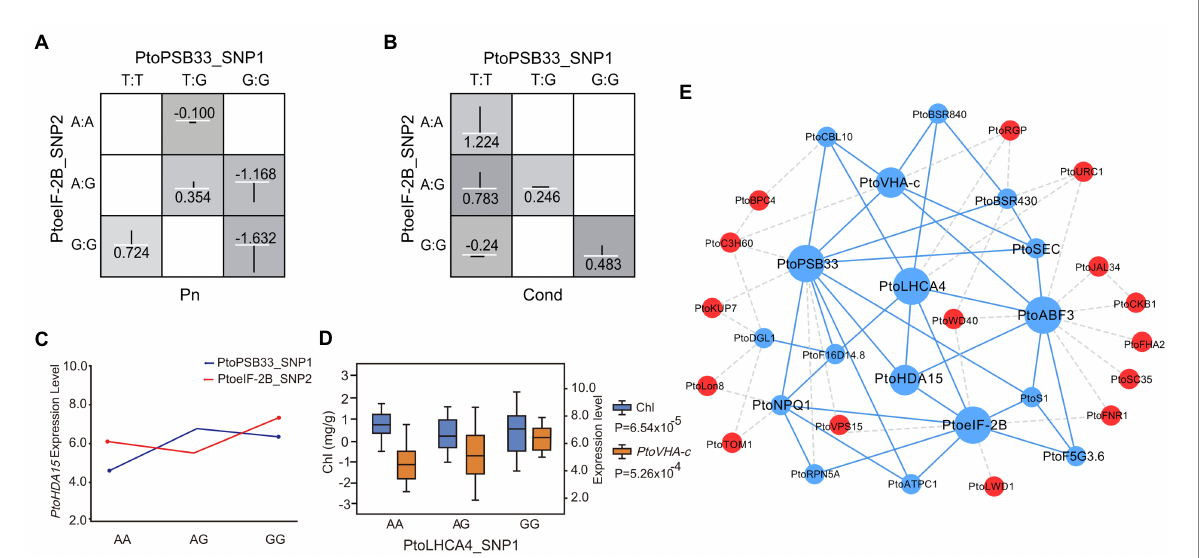
FIGURE 5 Integration of epistasis and eQTN analyses identifies factors involved in the response to drought stress. (A) and (B) Photosynthetic-trait epistatic effects of different genotypic combinations. (C) Pairwise interactions between PtoPSB33_SNP1 and PtoeIF-2B_SNP2 associate with the expression of PtoHDA15 with different genotypic combinations at the two loci. (D) Box plots for Chl (blue) and PtoVHA-c expression (orange) plotted as an effect of genotype at PtoLHCA4_SNP1. (E) Proposed network of interactions among genetic factors. Putative regulatory network of candidate genes constructed by association mapping and co-expression analysis. Blue circles represent genes with epistatic interactions while red circles represent association mapping-verified regulators. Dotted lines indicate potential interactions, including co-expression interactions; solid lines indicate interactions verified by association mapping and co-expression